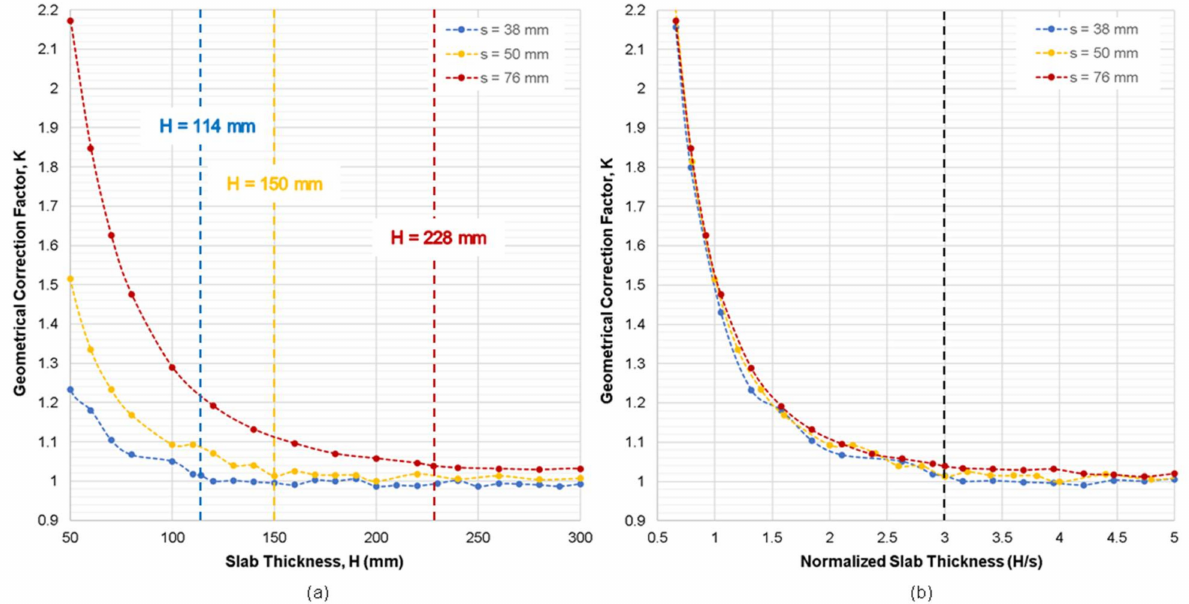
Figure 5. Variation of geometrical correction factor, K , obtained from the numerical simulation case 1 for the plain concrete slab model with respect to: ( a ) slab thickness, H , and ( b ) normalized slab thickness ( H /s).